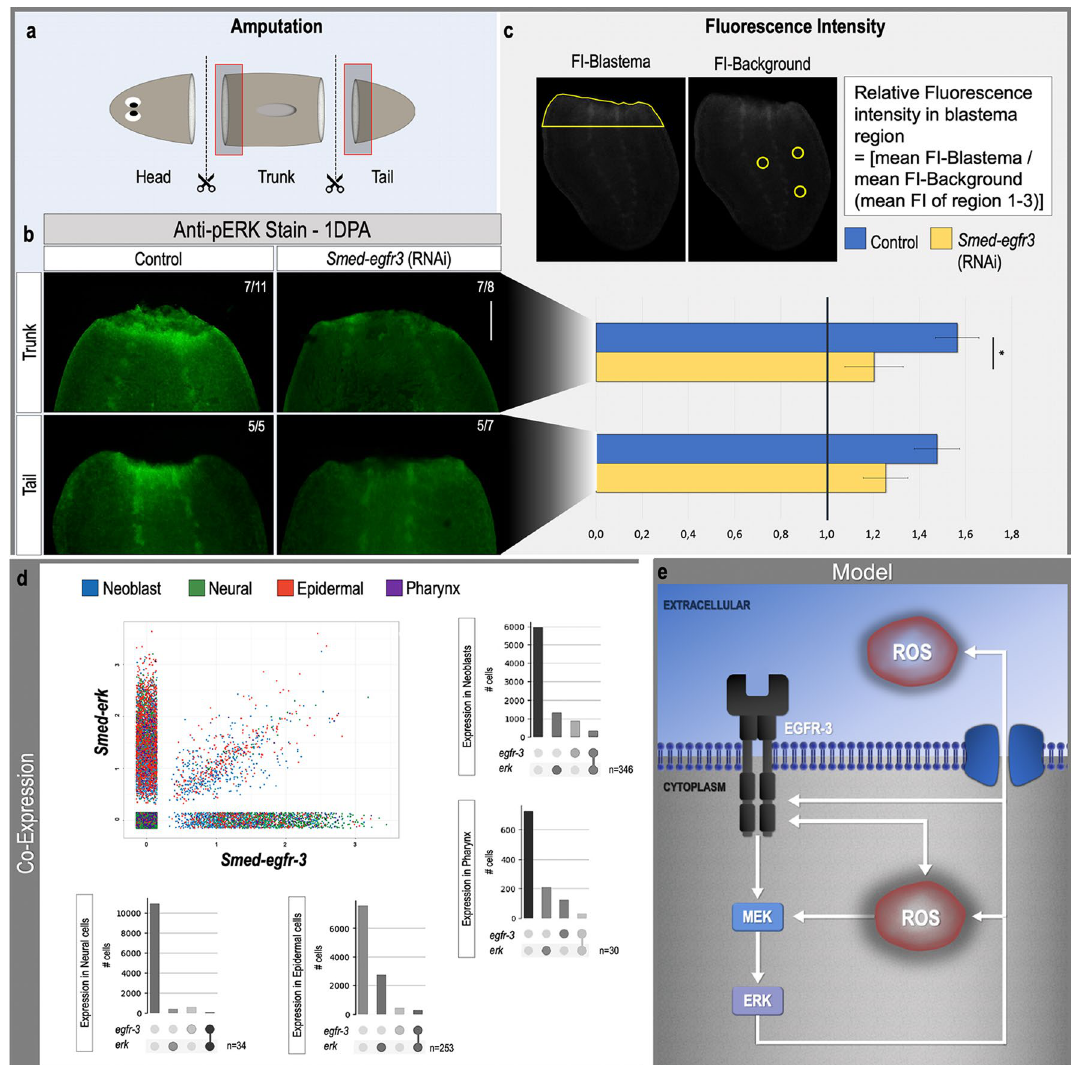
Immunostaining with an anti-pERK antibody in controls and after Smed-egfr-3 RNAi at 1 day post-amputation. All pictures were taken under the same light intensity settings. Sample numbers are indicated in the images. Scale bars 100 µm. ( c ) Relative fluorescence intensity of the blastema region. Setup of the measurement is indicated in the upper panel while the mean relative fluorescence intensity is displayed in the graph below. Color code as follows; dark blue: control, yellow: Smed-egfr3 RNAi. Statistical significance is indicated by: * p < 0.05; ** p < 0.01; *** p < 0.001. ( d ) Expression and co-expression of Smed-erk and Smed-egfr-3 based on single cell sequencing available 41,42 . For each of the lineages analyzed in each graph the first column represents the number of cells of that particular lineage in which neither Smed-egfr-3 nor Smed-erk are expressed. The second column indicates the number of cells expressing Smed-erk . The third column indicates the number of cells expressing Smed-egfr-3 . Finally, the fourth column indicates the number of cells in which Smed-egfr-3 and Smed-erk are co-expressed. ( e ) A possible regulatory pathway implicating ROS, Smed-EGFR-3, MEK and ERK is displayed based on literature and the results presented